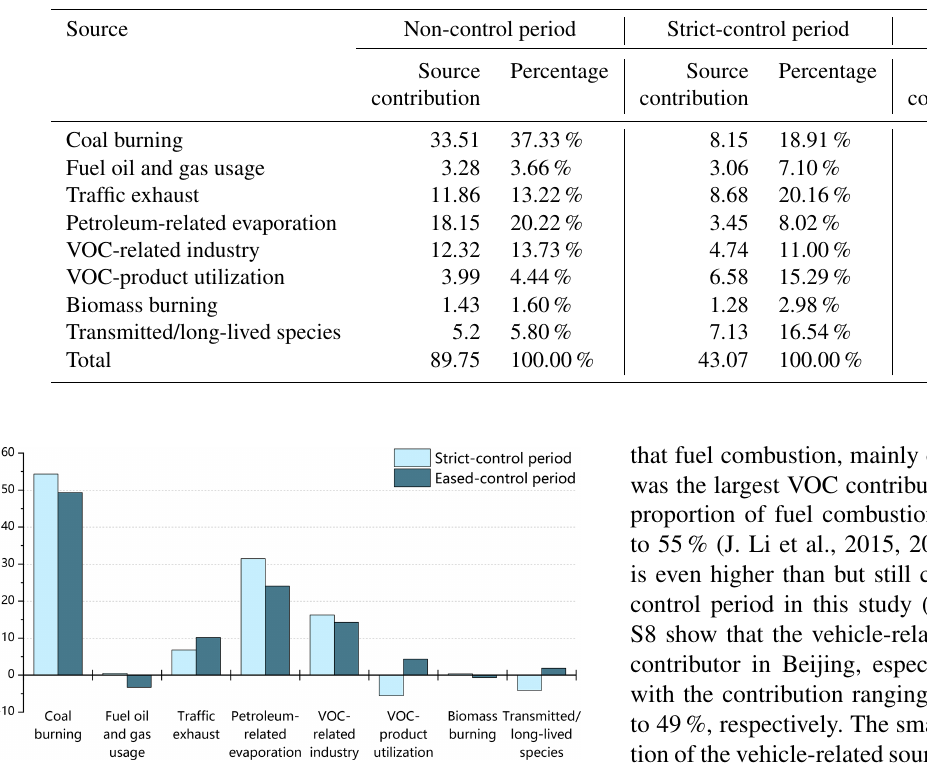
Table 2. Source contributions to ambient VOC mixing ratios (ppbv) and their contributions to total reduction compared with the non-control period (ratio) derived by PMF analysis.